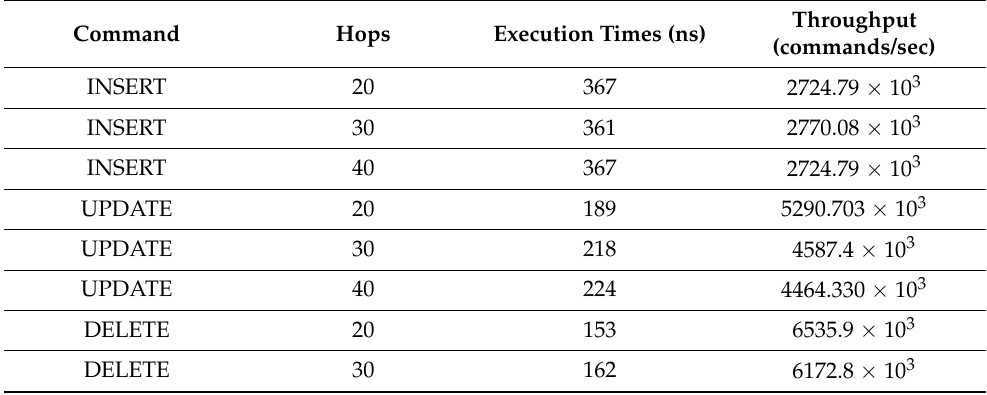
Table 7. Throughput for various commands with the pipelined execution of